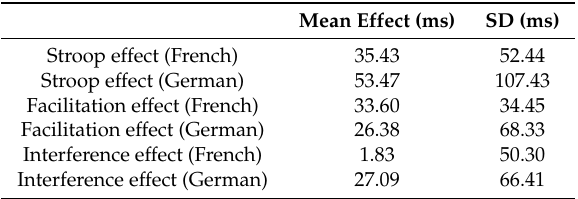
Table 4. Stroop effects of the French-German multilinguals in the French Stroop task and in the German Stroop